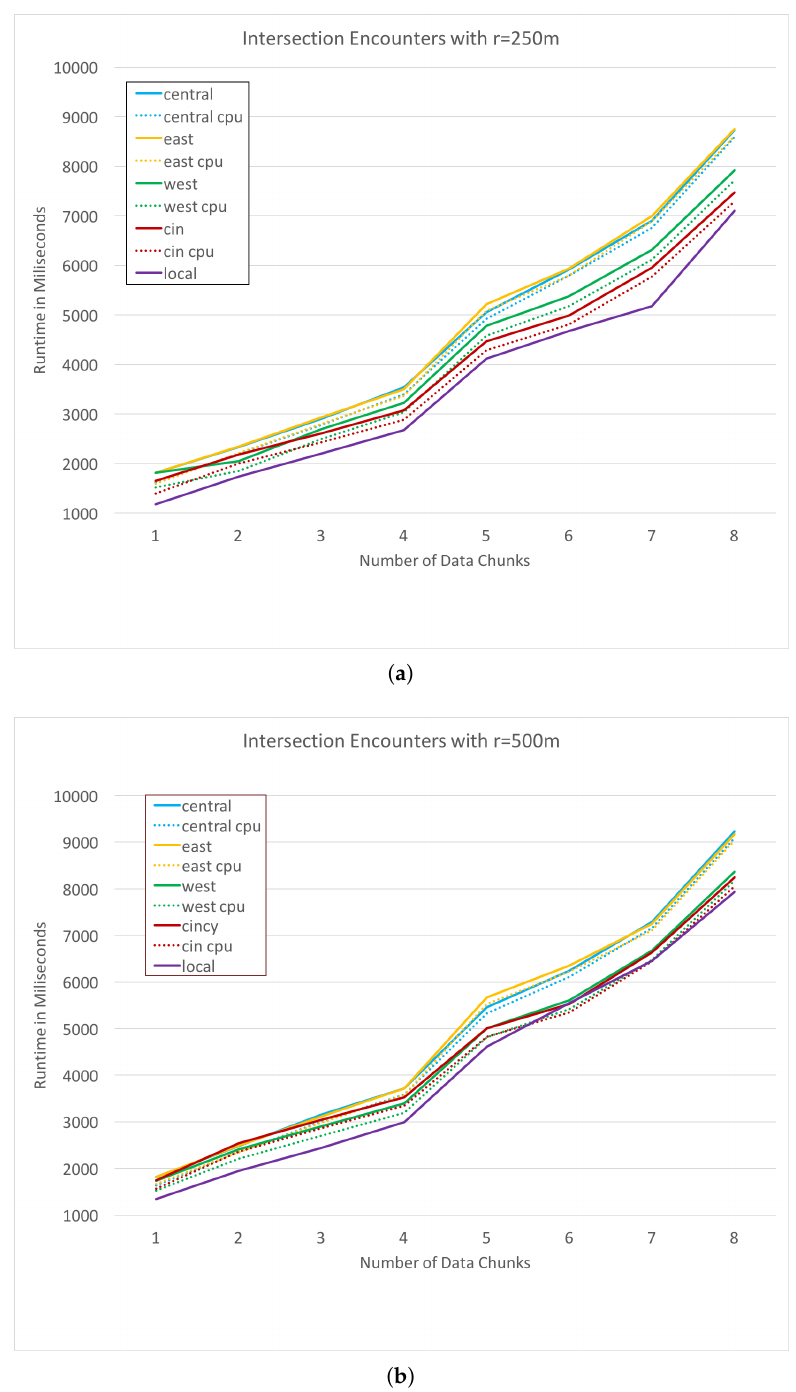
Figure 7. Intersection encounter analysis runtime with r = 250 m ( a ) and r = 500 m ( b